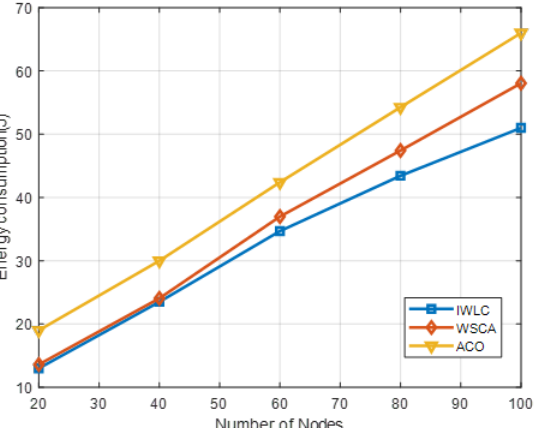
Figure 12. Energy consumption in different clustering schemes under different numbers of UAV nodes.